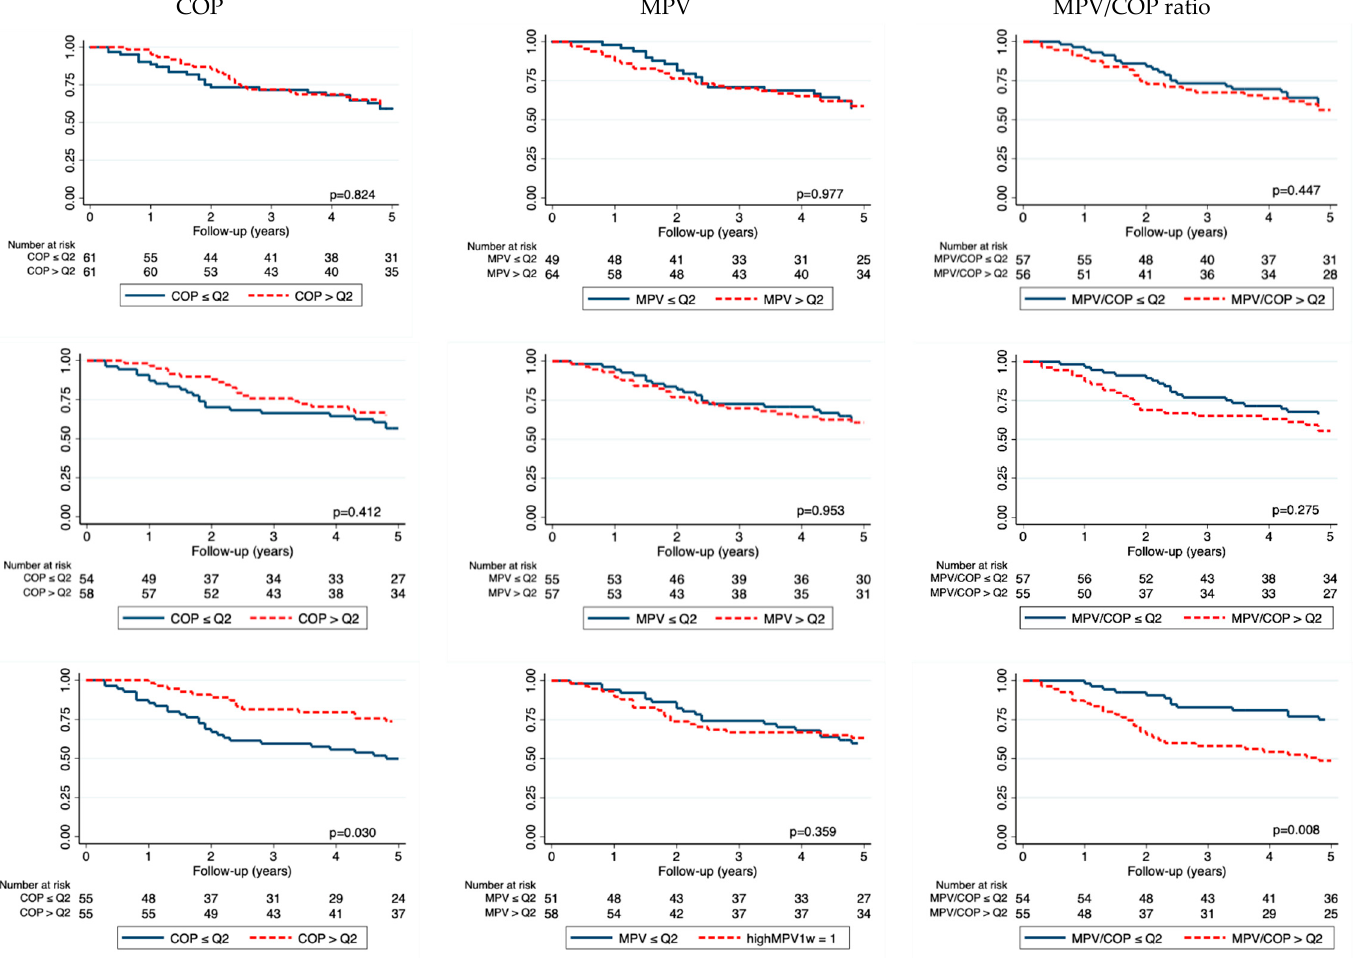
Figure 2. Kaplan–Maier curve according to preoperative (top rows) and postoperative (bottom rows) platelet indices for overall survival (OS). Y axis, surviving fraction. Abbreviations: Q2, median.